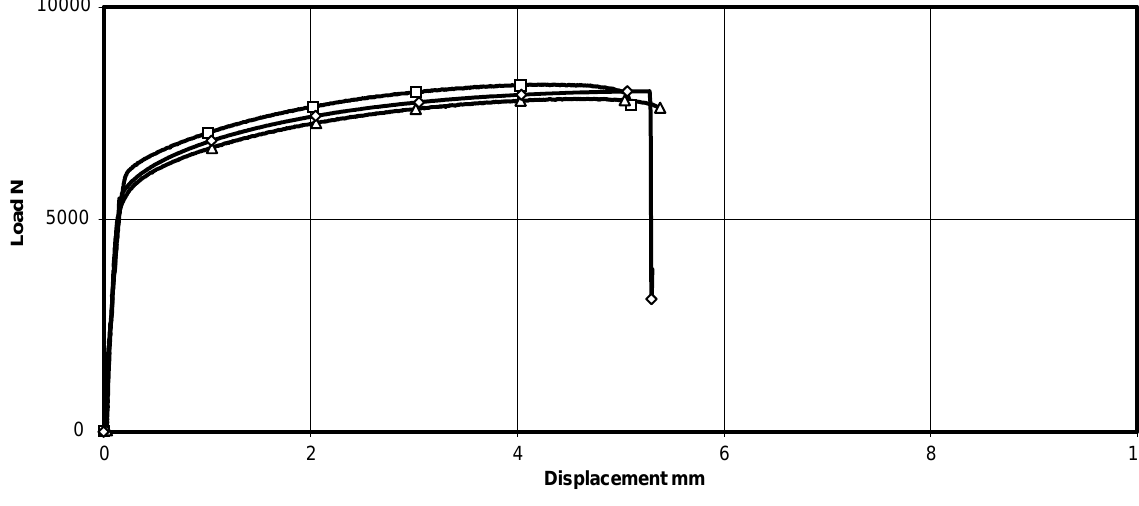
Fig. 15. Load vs. displacement diagram – Uniaxial tensile